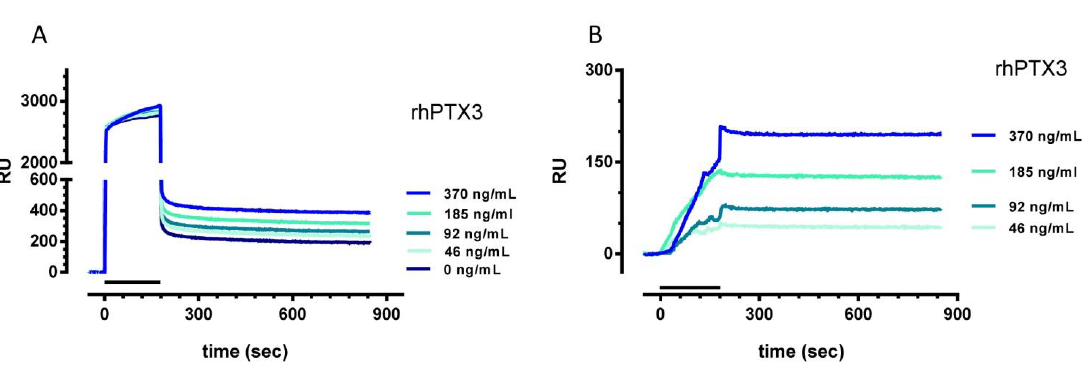
Figure 3. Binding of rhPTX3 to MNB4, in plasma. ( A ) Plasma of healthy subjects was spiked with different concentrations of rhPTX3 (0–370 ng/mL), diluted five-fold in PBST, and injected for 3 min (bar) at a flow rate of 30 µL/min, over the immobilized MNB4. ( B ) Normalized sensorgrams after subtraction of the signal with unspiked plasma. The running buffer was PBST, pH 7.4. Data are expressed as resonance units (RU) against